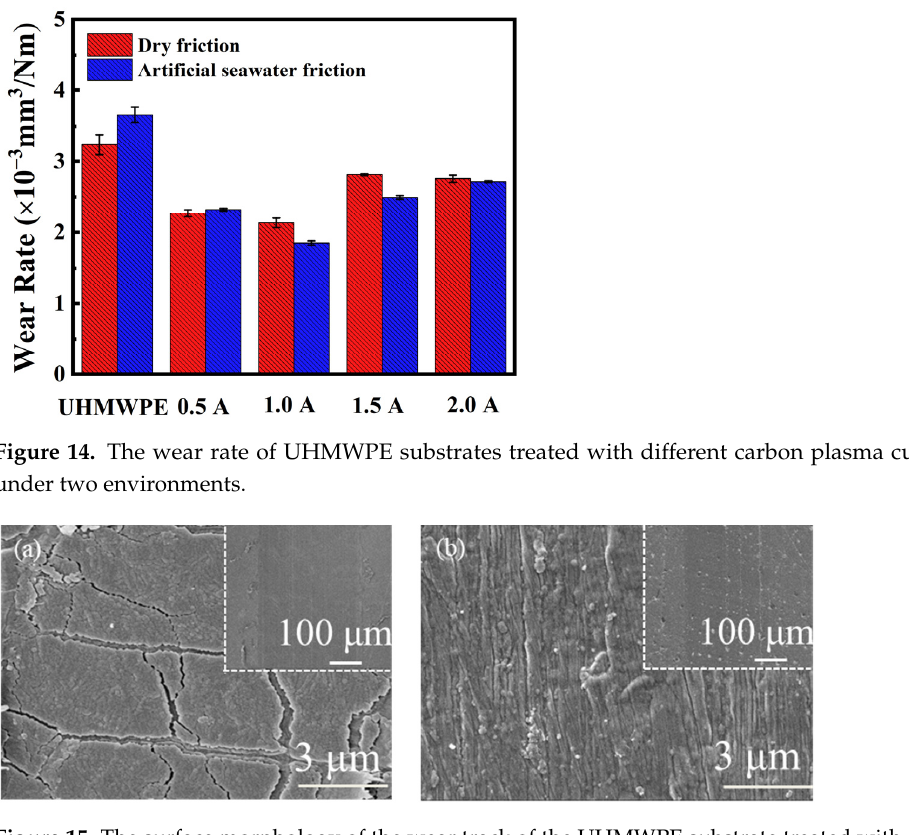
Figure 15. The surface morphology of the wear track of the UHMWPE substrate treated with carbon plasma of 1.0 A: ( a ) under dry friction, ( b ) under artificial seawater friction.